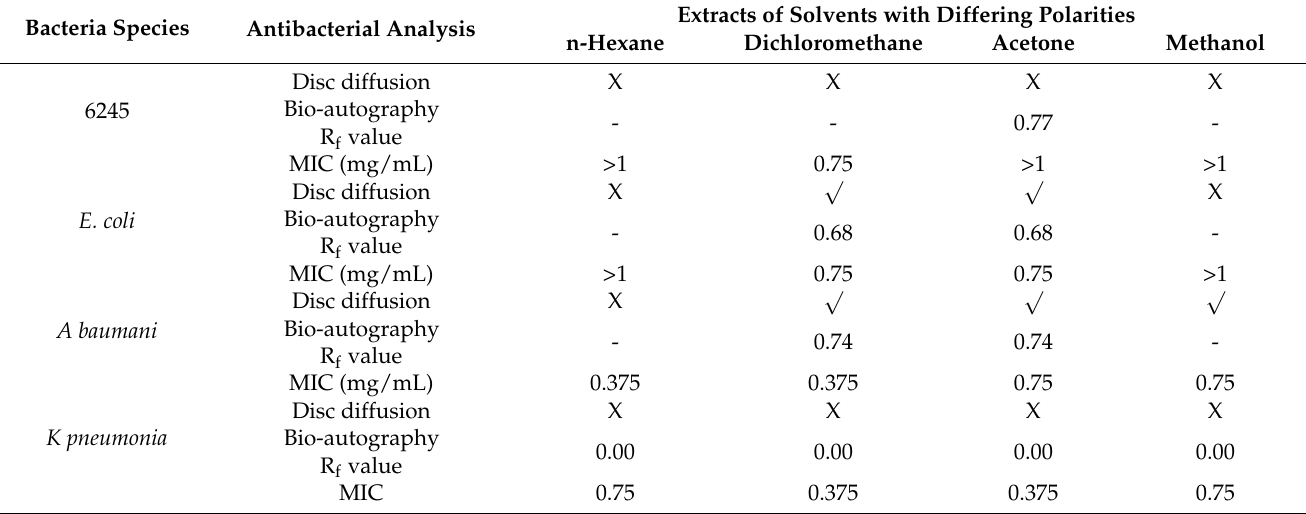
Table 5. Summary of the antibacterial properties of the extracts of Viscum continuum E.mey. ex Sprague. Extracts of Solvents with Differing Bacteria Species Antibacterial Analysis